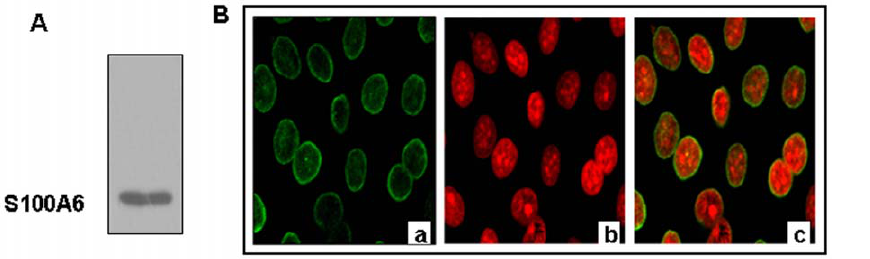
Figure 1. Endogenous expression of S100A6 in the MKN45 gastric cancer cell line. (A) Endogenous expression of S100A6 in MKN45 gastric cancer cells was detected by western blot. (B) Immunofluorescent staining of S100A6 in MKN45 cells. (a) Immunofluorescent staining of S100A6 with anti-S100A6 antibody (in green); (b) Detection of nuclei with propidium iodide (in red); (c) Merged picture.